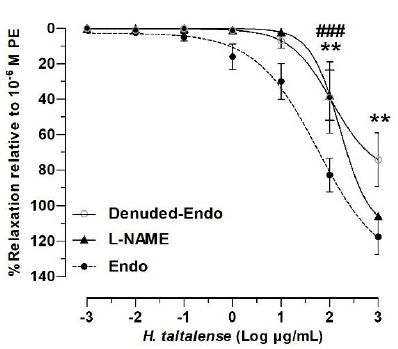
Figure 6. H. taltalense causes relaxation in rat aorta via the endothelium-dependent pathway. Aortic rings were pre-contracted with 10 −6 M PE, and cumulative concentrations of aqueous extract (0.001–1000 mg/mL) was added in bath. Protocol was repeated in intact rat aorta (Endo), in denuded-endothelium aorta (Denuded-Endo) and in pre-incubated tissue with 10 −4 M L-NAME. Data are the average standard error of the mean (SEM) of 3 independent experiments. ** p < 0.01 (Denuded-Endo), ### p < 0.001 (L-NAME) vs. Endo.